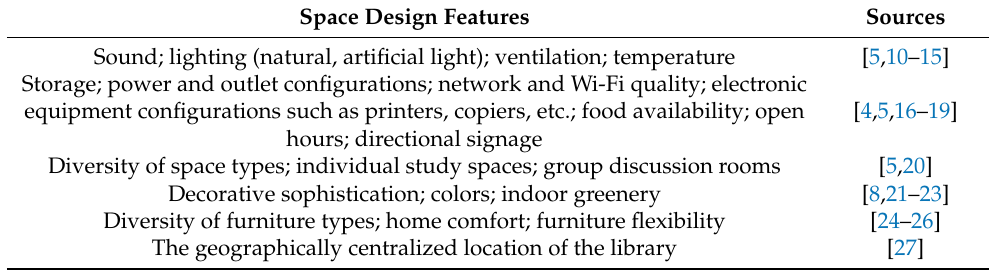
Table 1. Spatial design features of learning spaces that affect user experience based on available literature. Space Design Features Sources